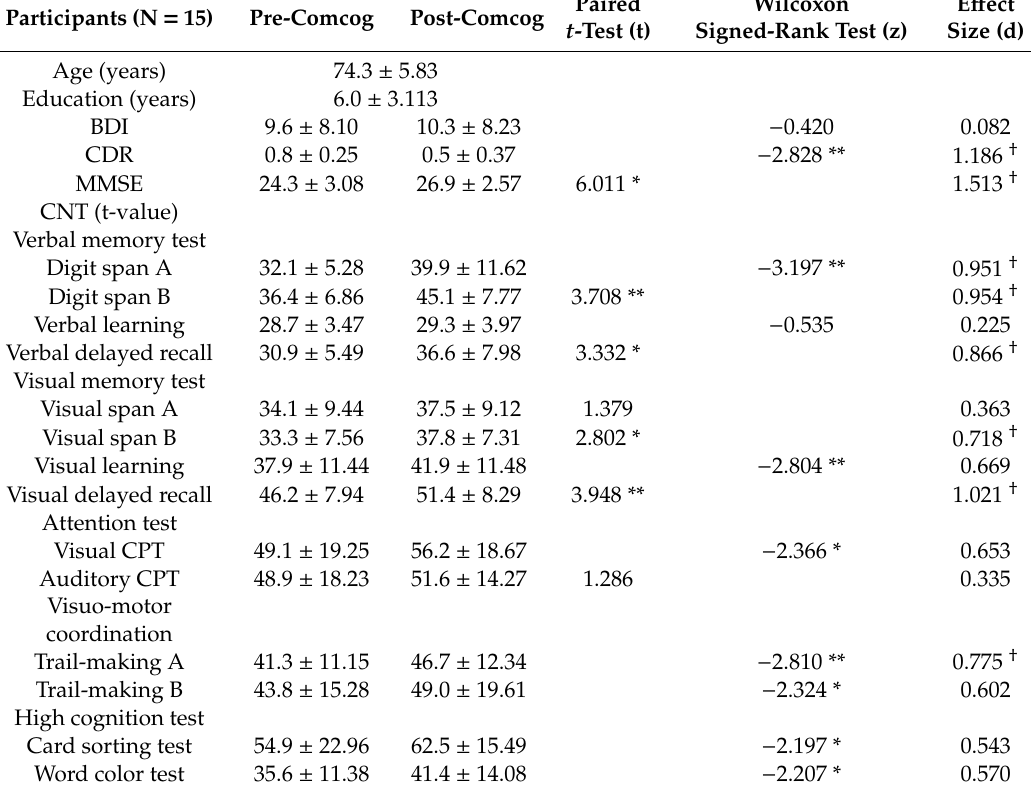
Table1. Demographicandneurocognitivecharacteristicsofparticipantswithmildcognitiveimpairment before and after Comcog